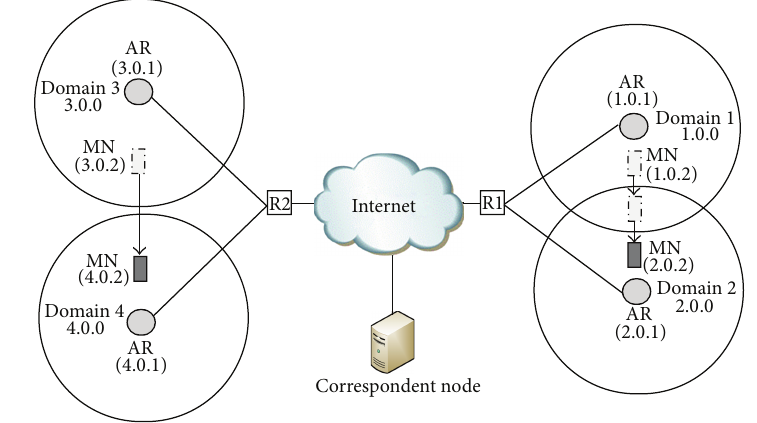
Figure 7: Network topology for mobility